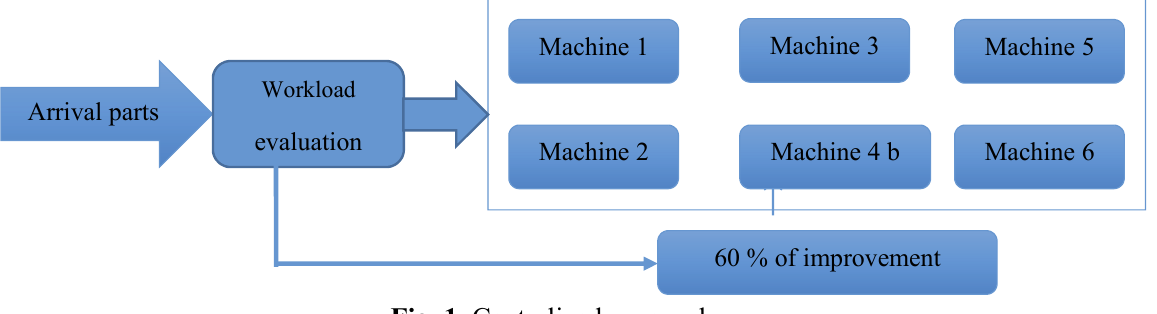
Fig. 1. Centralized approach